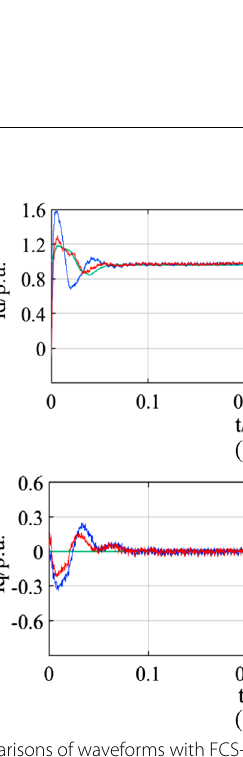
Table 3 Parameters of PI controller Parameters